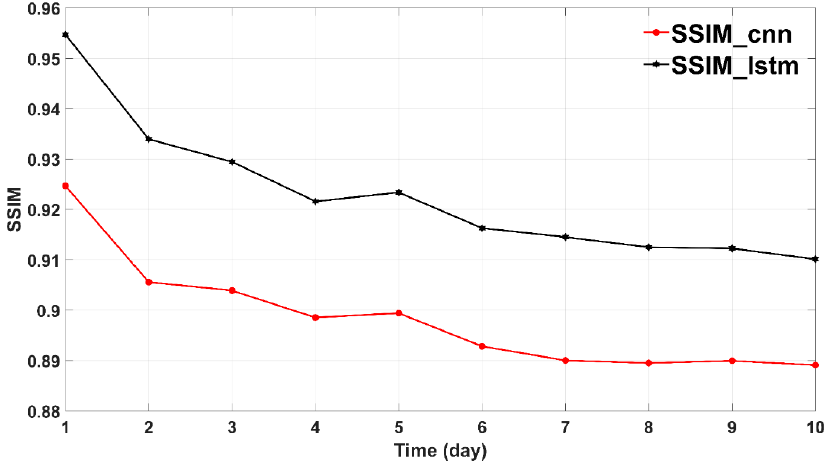
Figure 13. Comparison of the SSIM between the iterative prediction by the CNNs and ConvLSTM. The black and red lines represent the SSIM of ConvLSTM and CNNs, respectively.